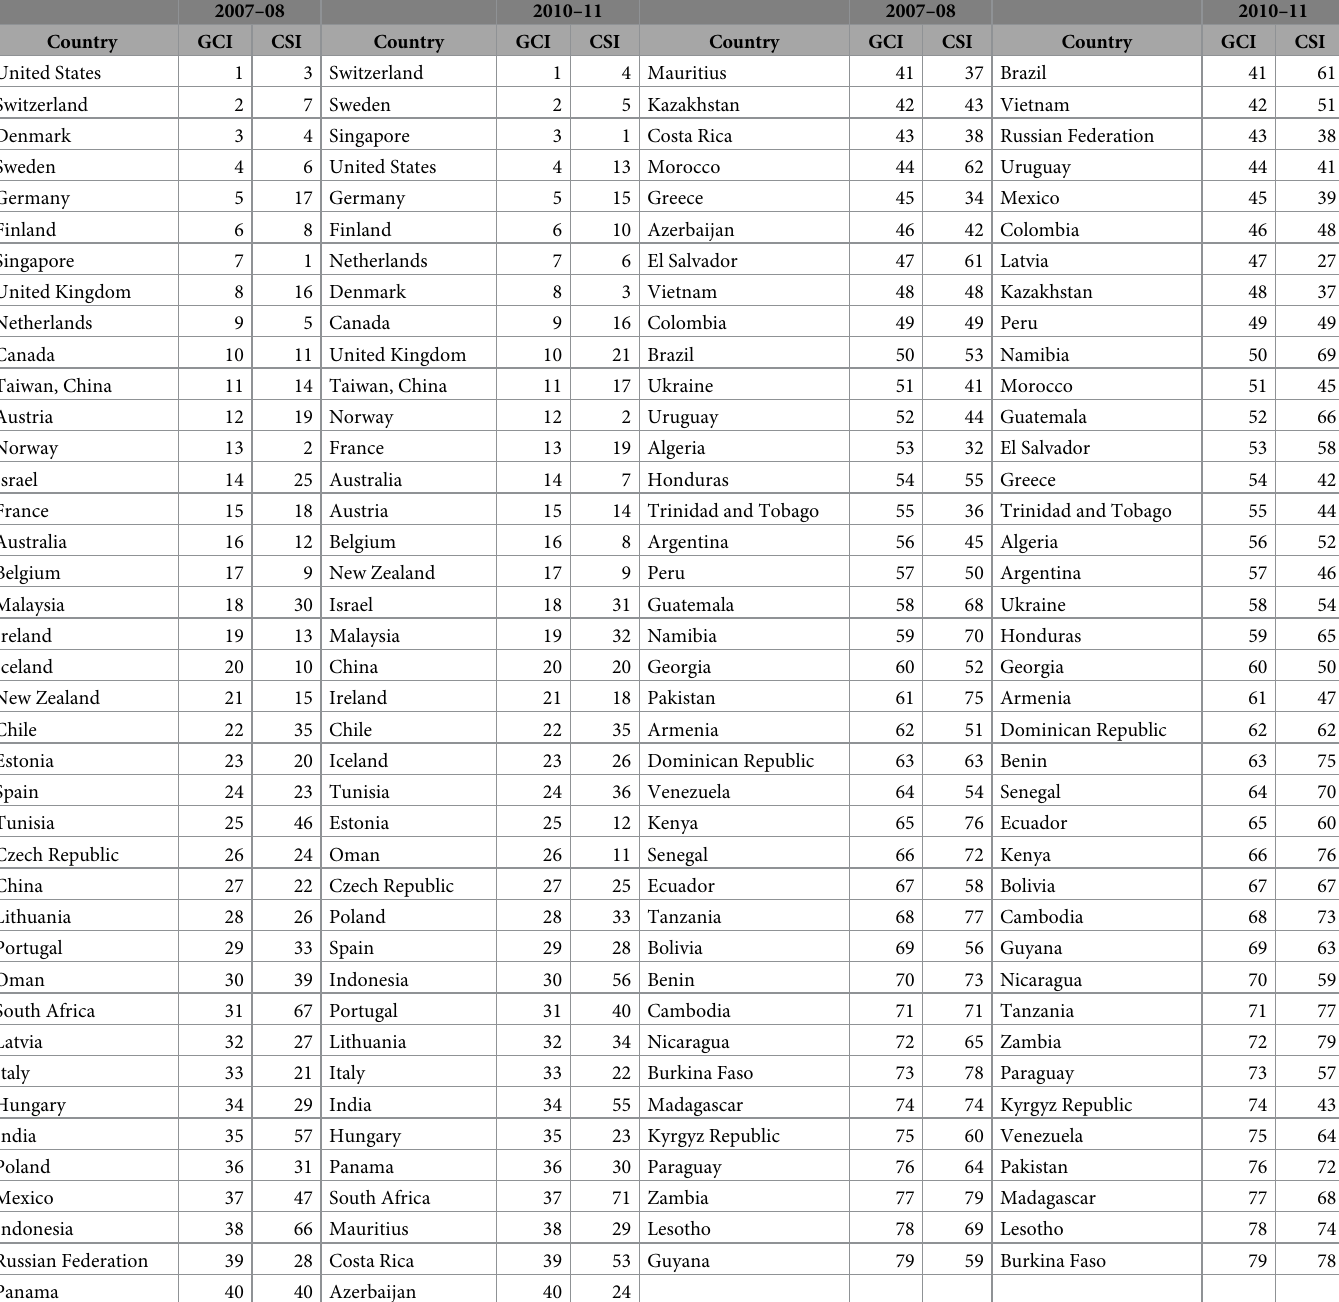
Table 7. Rankings and geographic distributions: WEF-GCI versus